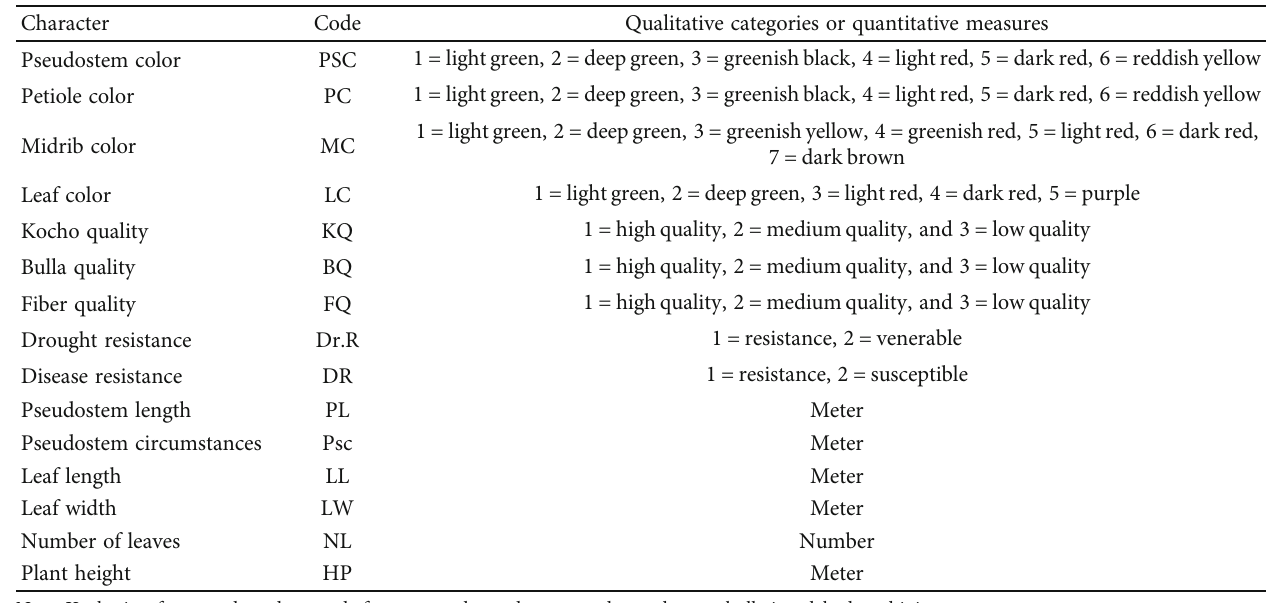
Table 2: The morphological characteristics of the study area ’ s enset landraces.